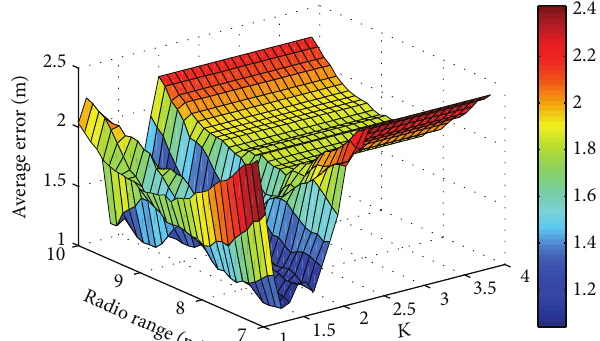
Figure 13: Average estimation error with different sensing radii and power-level ratios 𝑘 for path 2.